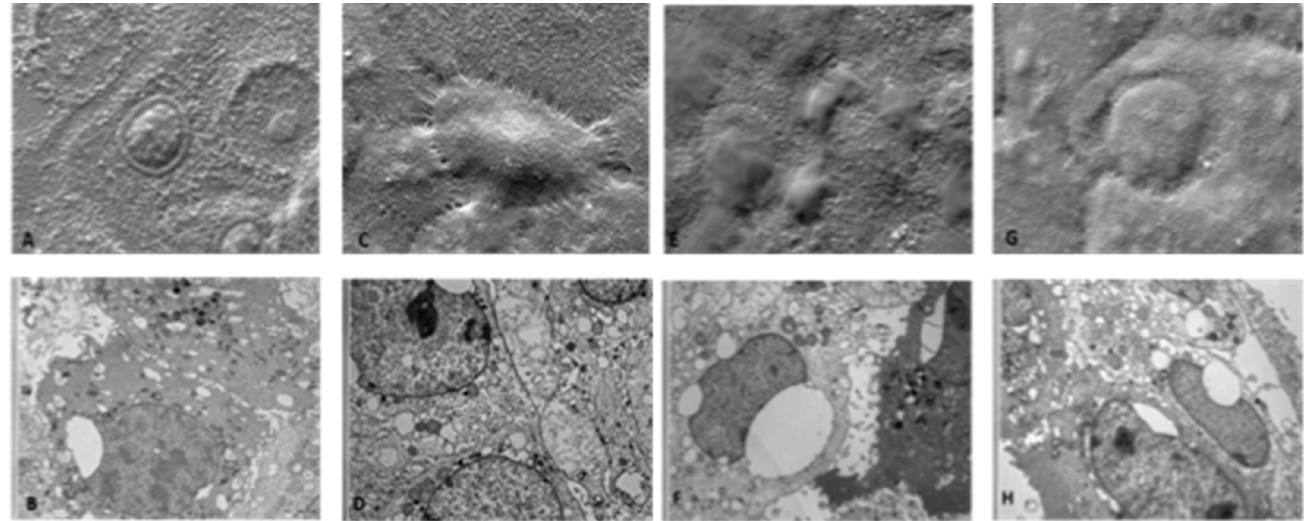
Figure 3. Effects of 300 and 5000 ppm HOCl nebulization on HaCaT cell morphology analyzed by SEM and TEM microscopies. ( A ) SEM image: T0h 300 ppm: SEM images show some cells with pycnotic nuclei and expanded cytoplasm in contact with neighboring cells. ( B ) TEM image T24h 300 ppm: the photomicrograph below at the same magnification shows cells with some vacuolations and lysosomal vesicles. ( C ) SEM image: T24h 300 ppm: SEM images show cells that tend to lose